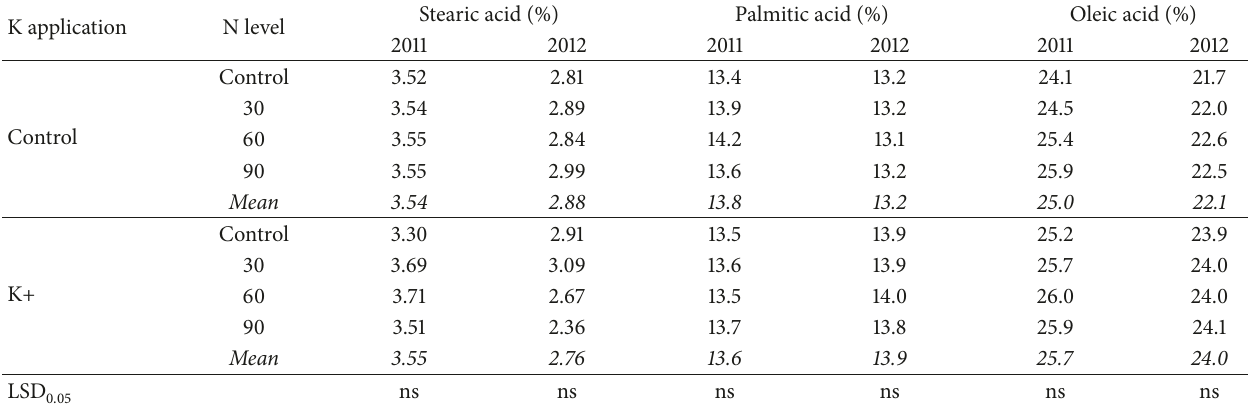
Table 5: Effects of N doses and K application on stearic, palmitic, and oleic acid of black cumin in 2011 and 2012. K application